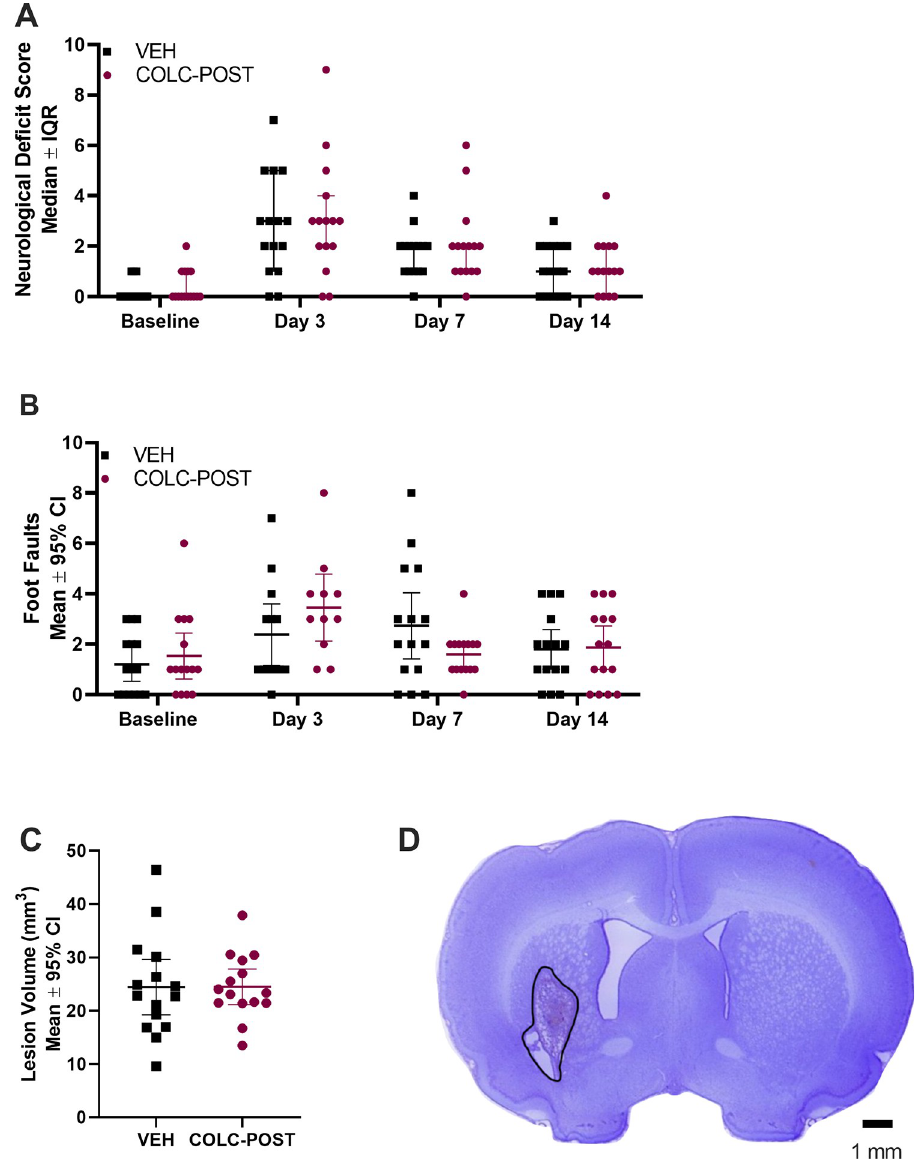
Fig 5. Experiment 4 behaviour and lesion volume. ICH significantly worsened NDS at all times post-ICH (A, p < 0.001), and performance on the ladder test at day 3 only (B, p = 0.016). No differences in NDS (p > 0.507) or ladder task (p = 0.791) were found between groups at any time. Lesion volume at 14 days post-stroke (C) was not affected by colchicine administration (p = 0.9848). D. Representative image of an animal from the colchicine group with a lesion volume of 21.47 mm 3 . This animal demonstrates ventriculomegaly and the hematoma resolution at 14 days post-ICH. Scale bar represents 1